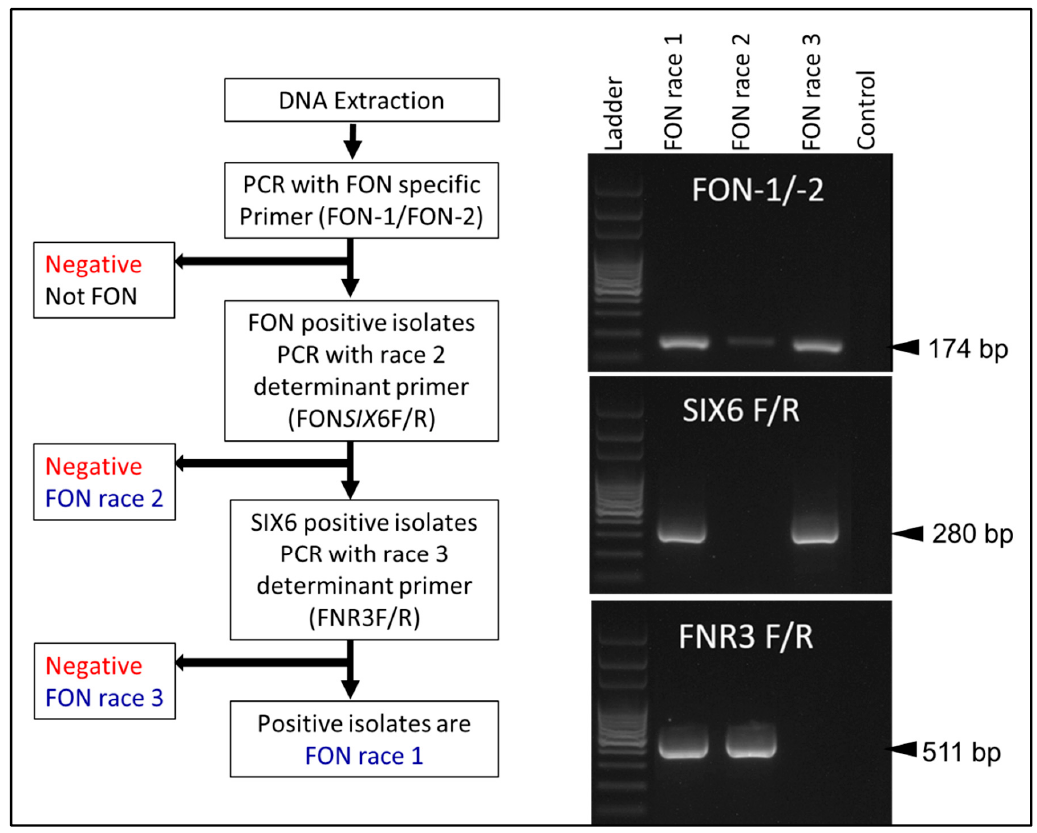
Figure 5. Molecular method of Fon race differentiation adopted from Hudson et al. (2021) [24] .